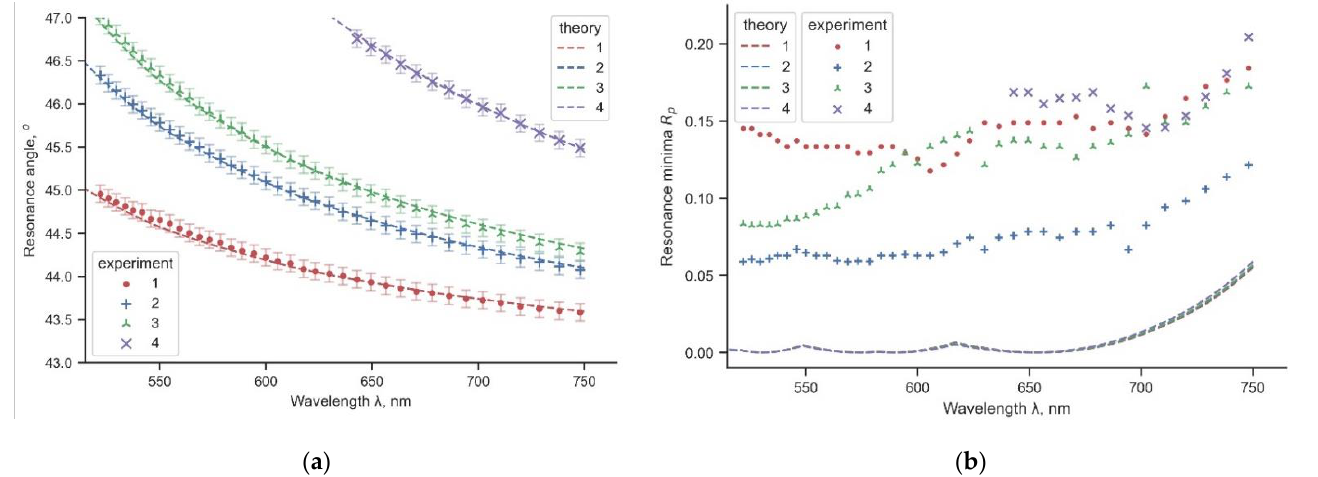
Figure 3. Experimental (solid) and simulated (dashed) resonance curves for different samples: 1—without a dielectric coating; 2, 3, and 4—with sequentially increasing coating thickness (see Table 1). The wide semi-transparent line shows the confidence interval: ( a ) dependence of the resonance angle on the wavelength; ( b ) dependence of the minimum of the reflection coefficient on the